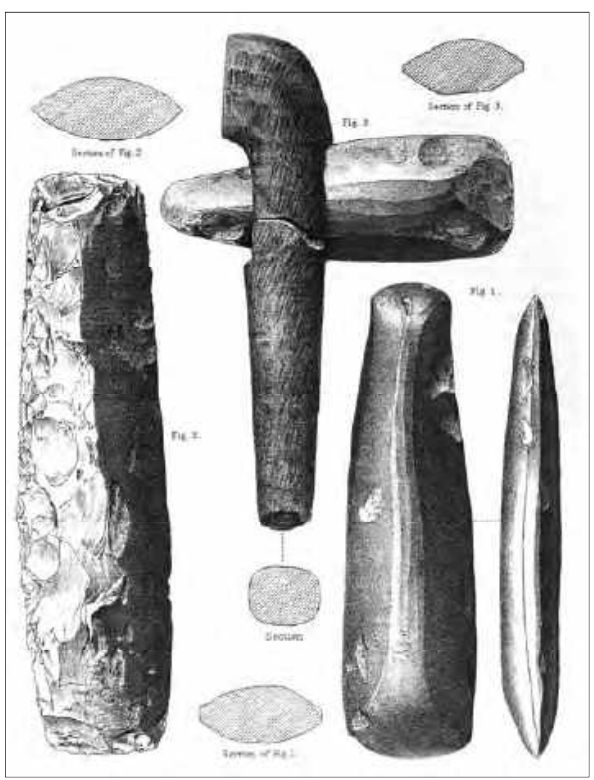
Fig 2.10 Artefacts recovered from Ehenside Tarn in 1869 (after Darbishire